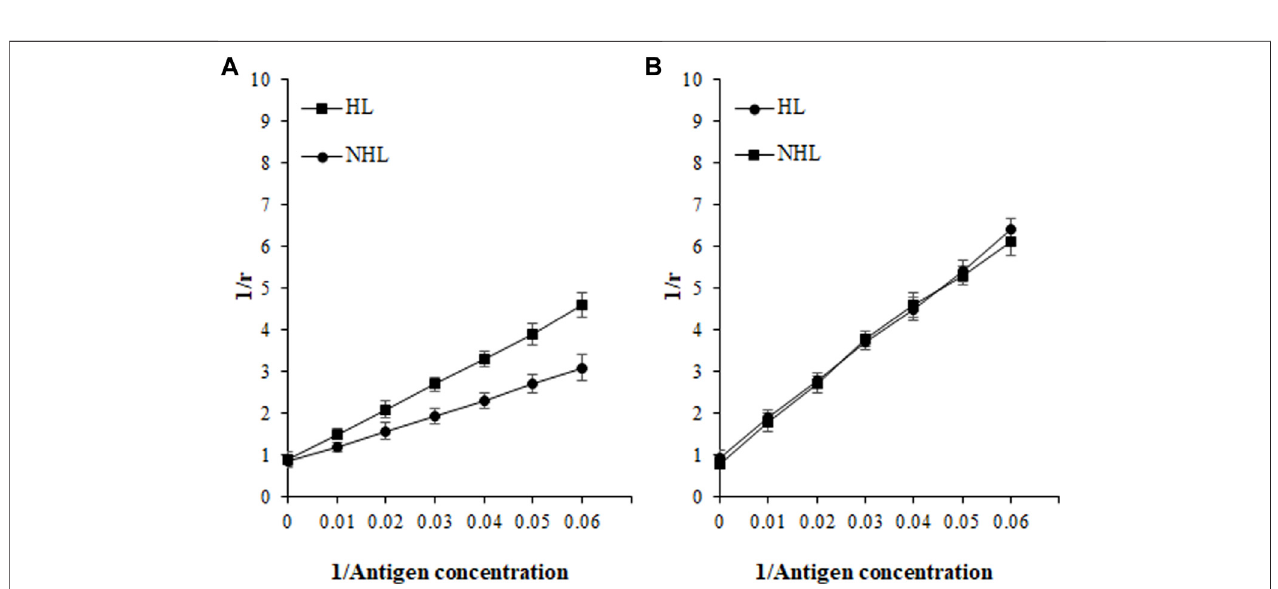
FIGURE 7 | Apparent association constants were calculated using the Langmuir plot for antigens ROS-His-H1 (A) and His-H1 (B) . A constant amount of IgG (100 µg)wasincubated withdifferentconcentrationsofantigen(0 – 40 µg)for 2 h at room temperature and overnight at 4 ° C.Langmuirplot ofthereciprocal ofthebound antigen concentration to antibody (1/r) versus the reciprocal of the free antigen concentration. ROS-His-H1 antigen and IgG binding for HL (- ■ -) and for NHL subjects (- C -).